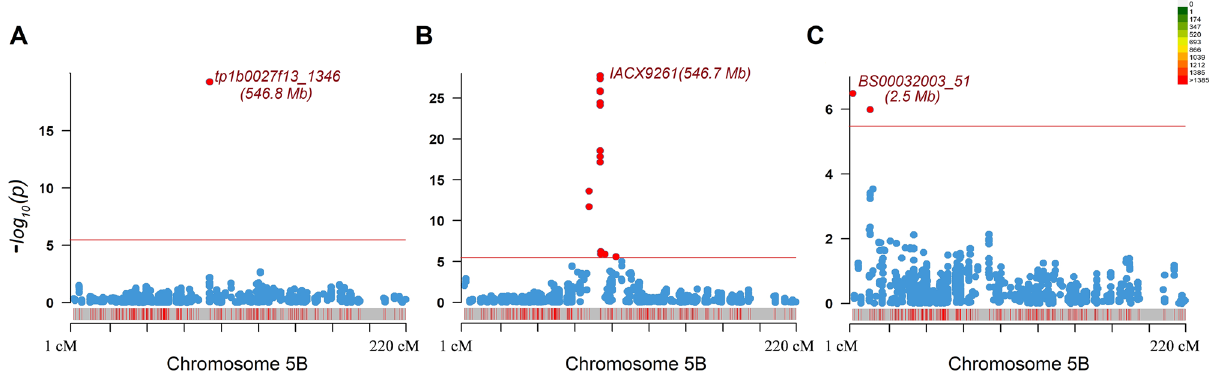
Figure 3. Marker-trait associations detected on chromosome 5B for (A) SNB inoculations, (B) SnToxA infiltrations, and (C) SnTox3 infiltrations. The color scale indicates SNP density on the bar given in the inset. The red line depicts the Bonferroni corrected threshold to declare significant associations. The physical location for the most significant SNP has been provided based on IWGSC RefSeq v 1.1 (2018).